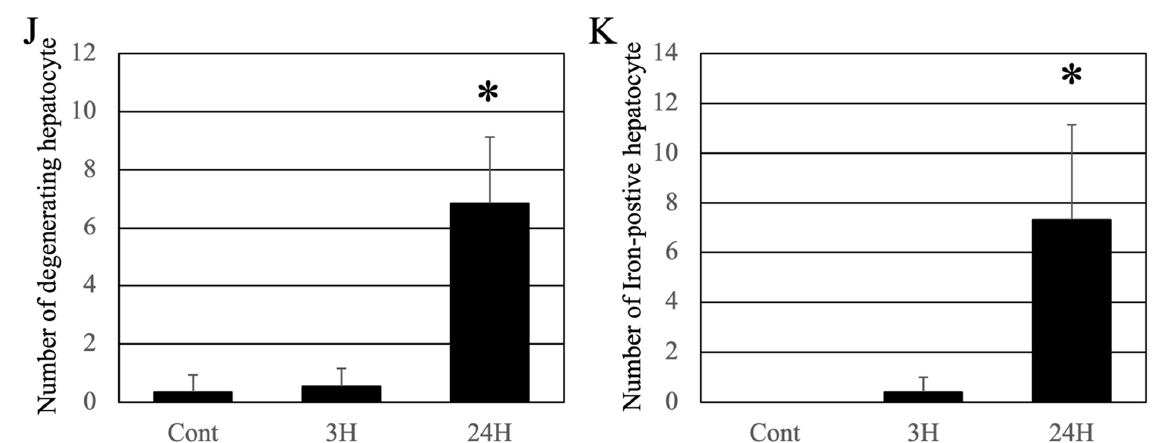
Figure 2. Control ( A , D , G ), 3H ( B , E , H ), and 24H ( C , F , I ) representative images of the hepatic tissues from the control animals and those from animals sacrificed at 3 and 24 h post-ammonia treatment, respectively. ( A – C ) are high-magnification views of the hematoxylin-eosin (HE) stained hepatic tissues, while ( D – F ) are high-magnification views of the Periodic acid–Schiff (PAS) stained hepatic tissues. ( G – I ) are high-magnification views of the Iron-stained hepatic tissues. Black arrows indicate the hepatocytes exhibiting swelling and/or cytoplasmic vacuolization. Red arrows indicate the iron-positive sites. All scale bars = 100 µ m. ( J ) shows the number of hepatocytes exhibiting swelling and/or cytoplasmic vacuolization. ( K ) shows the number of iron-positive hepatocytes. Data are expressed as mean ± standard deviation. * p < 0.05, compared to the